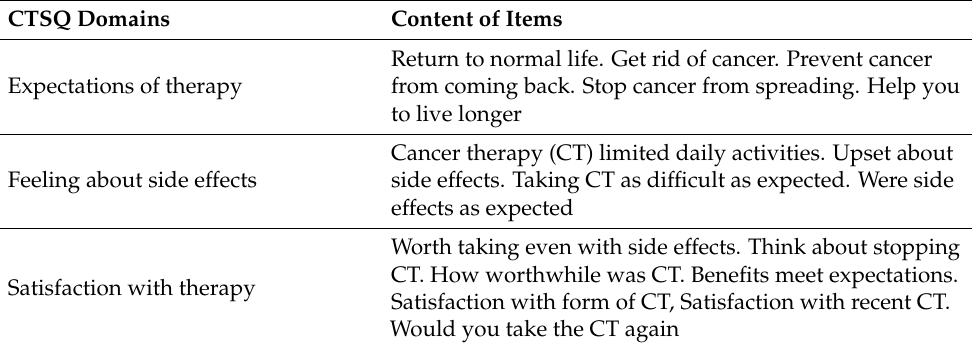
Table 1. Cancer therapy satisfaction questionnaire (CTSQ) domains. https://docplayer.net/51309772 -Administration-and-scoring-guide-for-the-cancer-therapy-satisfaction-questionnaire-ctsq.html (ac- cessed on 12 February